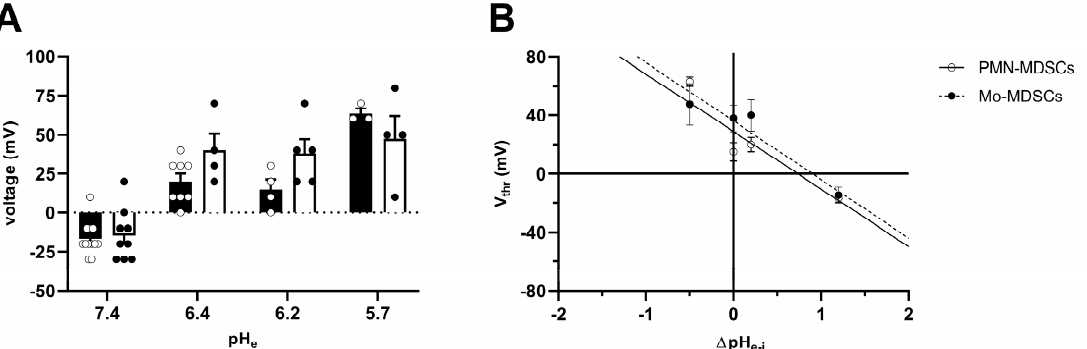
Figure 9. Effect of pH e on the activation threshold (V thr ) of Hv1 in murine PMN- and Mo-MDSCs. ( A ) Bars and error bars indicate the mean ± SEM (PMN-MDSCs–7.4: n = 12, 6.4: n = 8, 6.2: n = 4, 5.7: n = 3; Mo-MDSCs–7.4: n = 9, 6.4: n = 4, 6.2: n = 5, 5.7: n = 4) of the voltage threshold (V thr ) calculated using the family of currents for each pH e condition (see Materials and Methods and Figure 8E,F). The pH of the pipette filling solution was pH i = 6.2. Symbols indicate individual data points obtained in PMN-MDSCs (empty circles and black-filled bars) and Mo-MDSCs (black-filled circles and empty bars). ( B ) V thr plotted against ∆ pH e–i (pH e − pH i ) in PMN-MDSCs (empty circles) and Mo-MDSCs (black-filled circles). The shift in V thr by moving pH e of one unit was determined by the slope of the linear intercept (PMN-MDSCs: − 39.36 mV/ ∆ pH, R 2 = 0.7769; Mo-MDSCs: − 40.07 mV/ ∆ pH, R 2 = 0.6465). Every value with its error bar indicates the mean ± SEM.